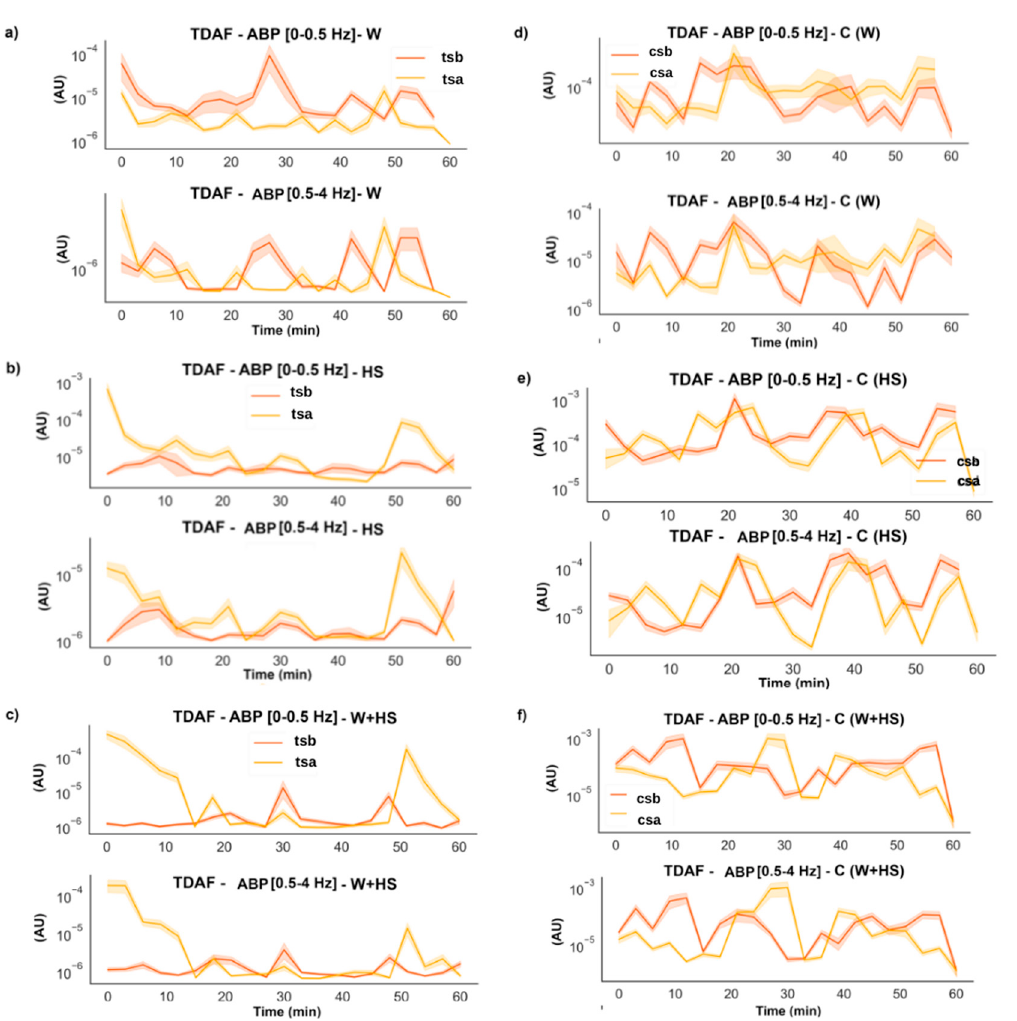
Figure 8. TDAF graphs for ABP analysis for low and delta frequencies. Results for ( a ) the systemic wound (W), ( b ) heat shock (HS), and ( c ) wound + heat shock (W+HS). Results of the control plants for ( d – f ) wound C (W), heat shock C (HS), and wound + heat shock C (W+HS), respectively. tsb: treated systemic before stimulus; tsa: treated systemic after stimulus; csb: control systemic before stimulus; csa: control systemic after stimulus. AU: arbitrary unit.